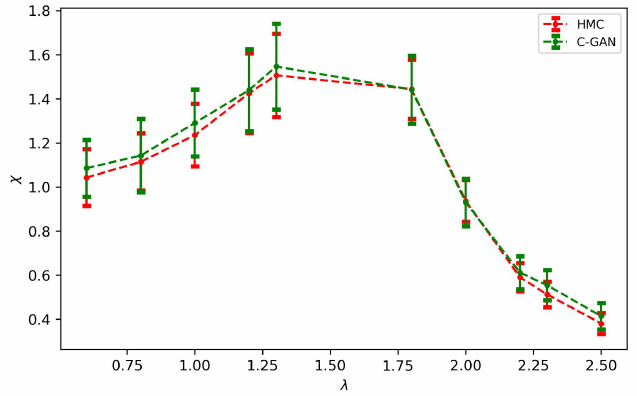
Figure 5: Susceptibility and its standard deviation on λ samples with bin size of